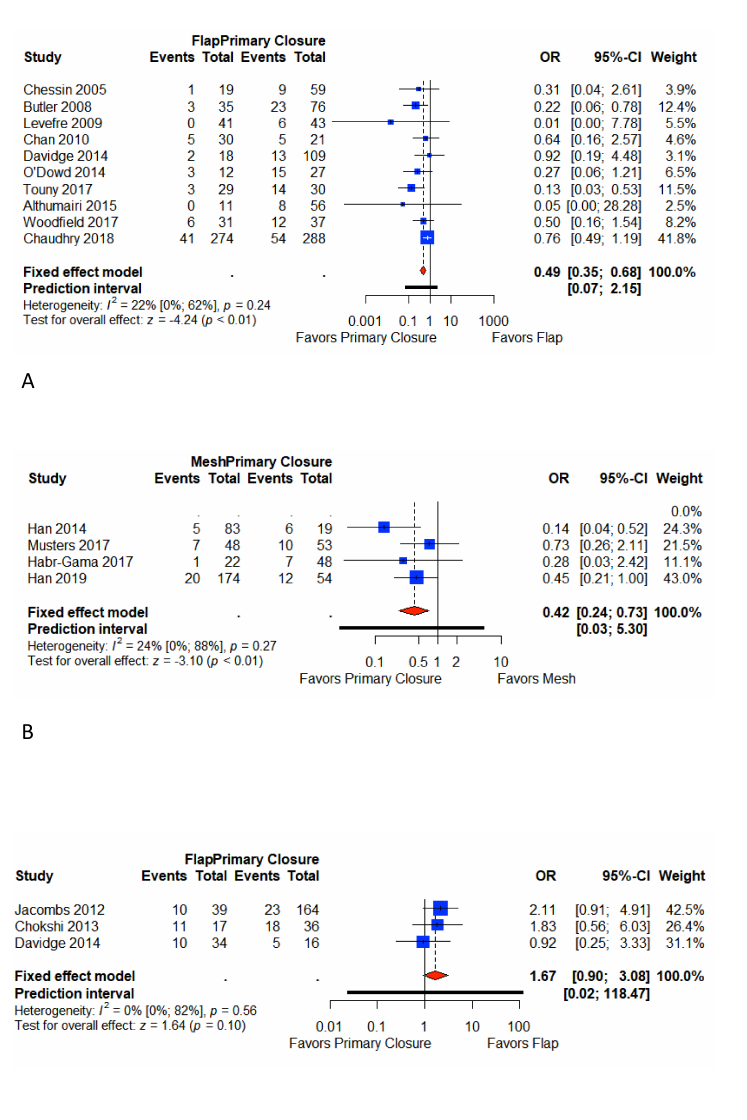
Figure 3. Forest plot for major perineal wound complications between patients with primary closure and with flap closure ( A ); forest plot for major perineal wound complications between patients with primary closure and with mesh closure ( B ); forest plot for major perineal wound complications between patients with primary closure and with flap closure in pelvic exenteration ( C ). Odds ratio: overall ratio of major perineal wound complications when comparing primary closure with flap closure. All weights are from random effects analysis. M–H, Mantel–Haenszel.